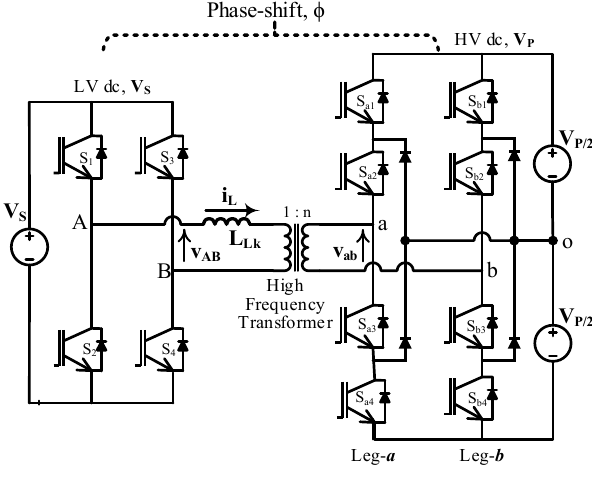
Figure 1. Boost configuration ( (cid:1848) the transformer primary voltage ( (cid:1874)